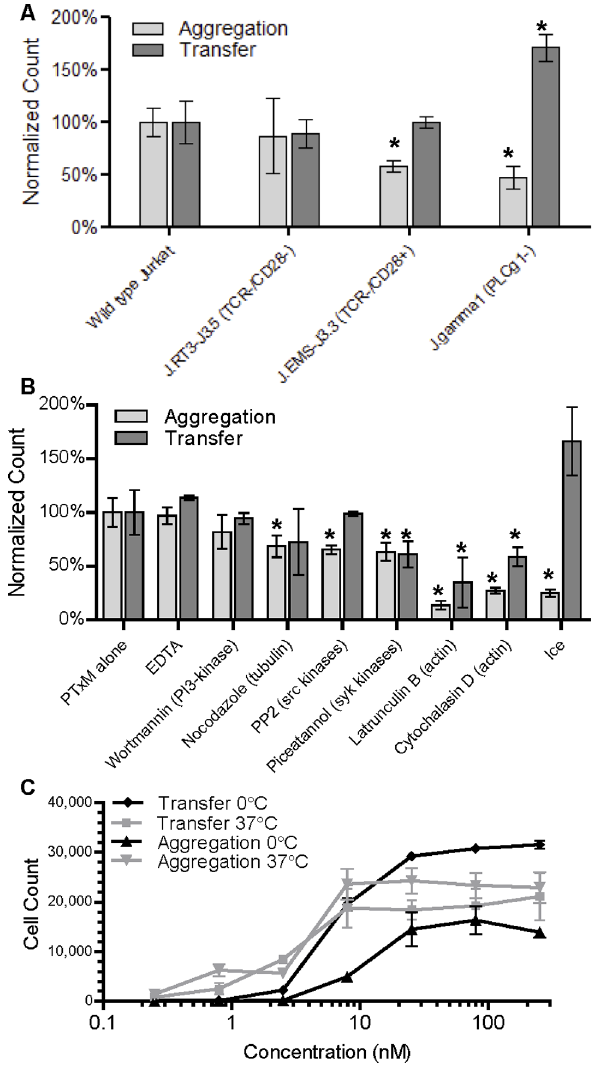
Figure 4. Effect of inhibitors and mutation on aggregation and transfer. A. Comparison of PTxM treatment (7.9 nM for 1 hr at 37 u C) of Jurkat cell lines and derivatives, E6-1 (wild type), J.RT3-J3.5 (TCR 2 / CD28-), J.EMS-J3.3 (TCR 2 /CD28 + ), and J.gamma1 (PLC- c 1-), for aggregation (light grey) and transfer (dark grey). Population sizes are normalized to the mean wild type aggregation or transfer. Results represent the mean of three independent assays with standard deviation. * indicates significant difference from wild type by Student’s T-test (P , 0.05). B. Comparison of PTxM treatment (7.9 nM for 1 hr at 37 u C) of Jurkat cells pretreated under differing conditions for aggregation (light grey) and transfer (dark grey). Population sizes are normalized to the mean aggregation or transfer under non-pretreated conditions (PTxM alone). Results represent the mean of three independent assays with standard deviation. * indicates significant difference from PTxM alone by Student’s T-test (P , 0.05). C. A dose- response study examining the amount of aggregation versus mem- brane transfer as a function of PTxM concentration at 37 u C and on ice. Results represent the mean of three independent assays with standard deviation. Both the S2S4 and S3S4 dimers mediated aggregation (Fig. 7A), although intact PtxM (with four glycan binding regions) was able to promote a higher level of aggregation than the dimers.